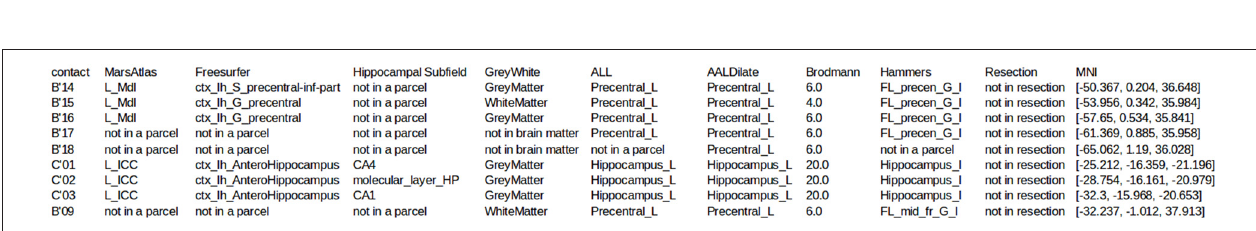
Frontiers in Neuroinformatics |